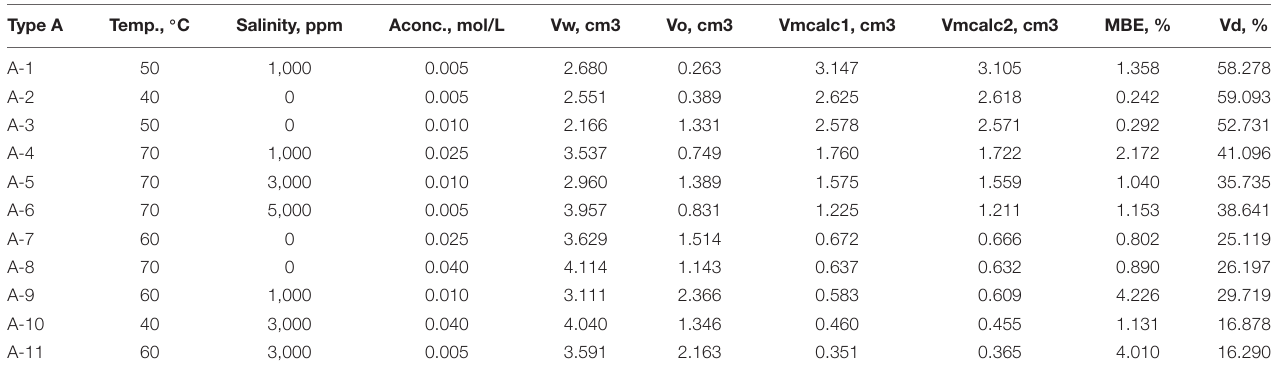
TABLE 3 | Na 2 CO 3 orthogonal test phase migration volume fraction of 3-phase distribution